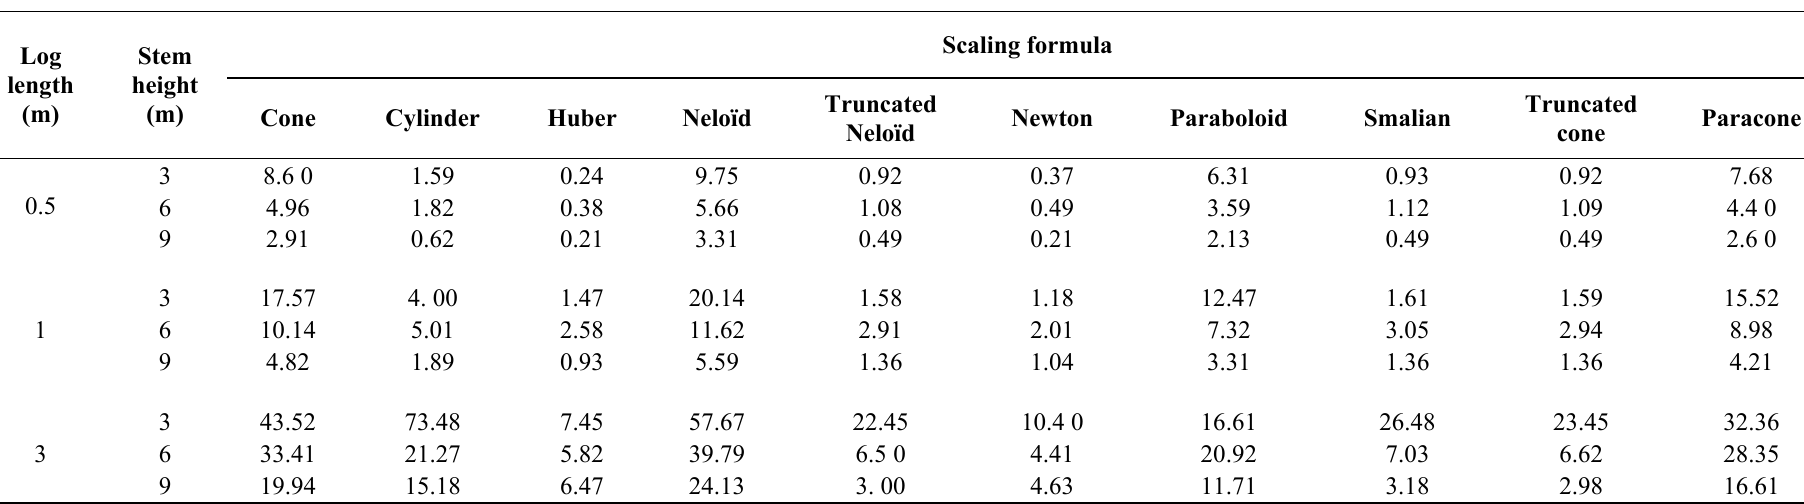
Table 5. Mean values of the root mean square error (RMSE) by sampling height and length of the ridge of different methods of scaling. Log length (m)